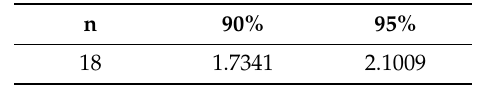
Table 5. Critical values for insurance companies. Source Pearson’s table.